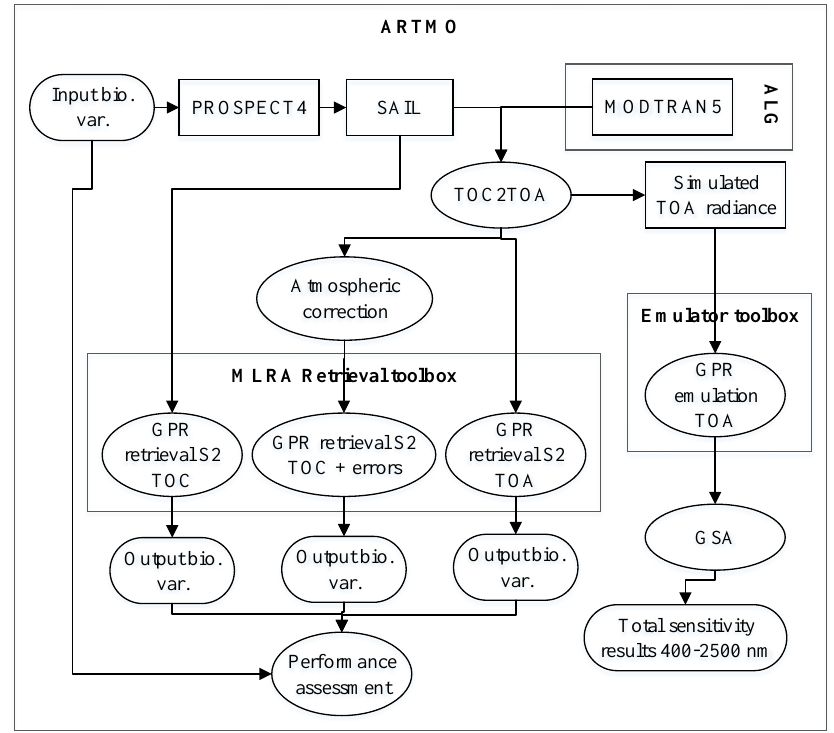
Figure 2. Flowchart of the pursued work-flow, divided into the Global Sensitivity Analysis (GSA) study ( right ) and retrieval performance assessment ( left